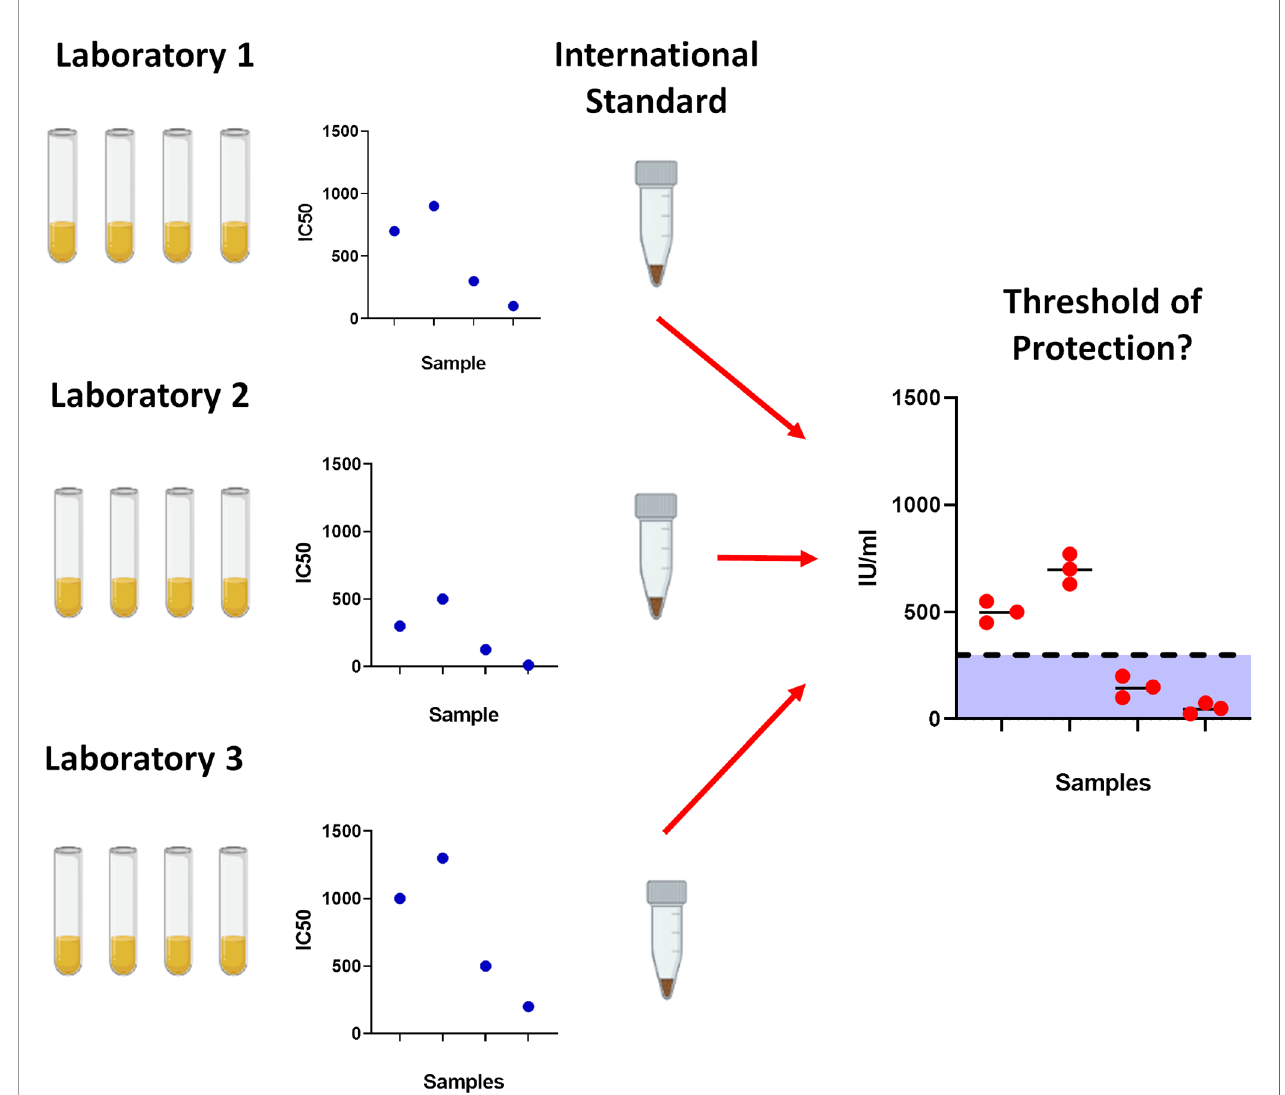
FIGURE 1 | Importance of using the World Health Organisation International Standard serum. To prevent laboratory to laboratory variability between assays, the International Standard was created to standardise results which would allow for cross laboratory comparisons. With gradual accumulation of data, this would permit further analysis into determining correlates for protection against